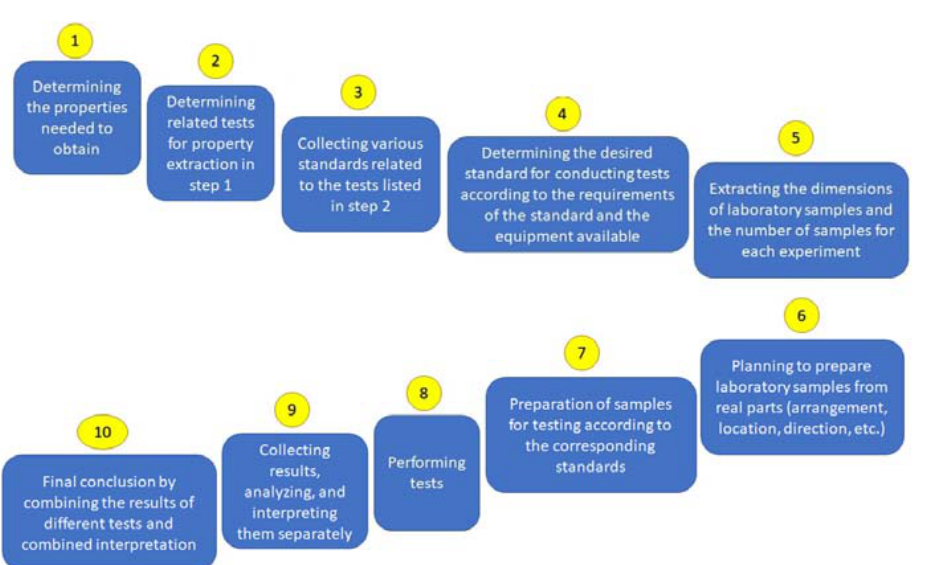
Figure 1. The proposed flowchart for RE of 3D printed metals with the aim of estimating the load-bearing capacity.